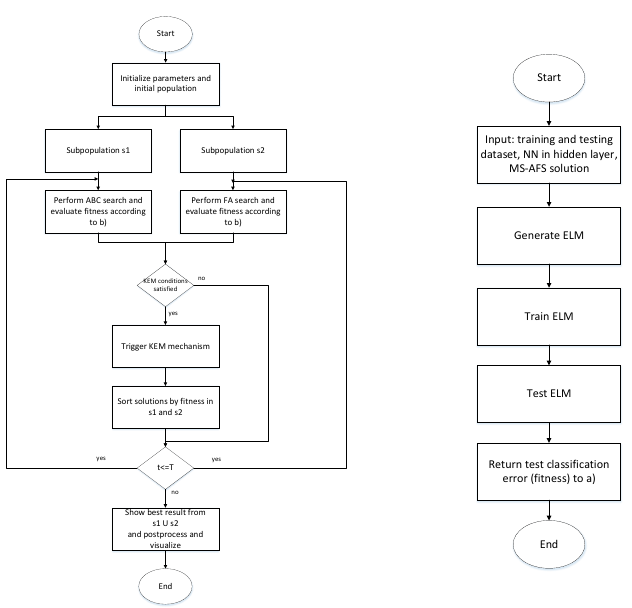
Figure 1. Overview for the proposed ELM-MS-AFS approach.